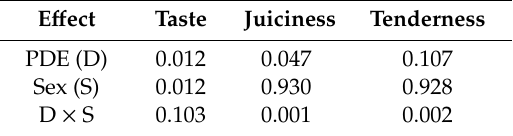
Table 8. The p values for PDE addition and pig-sex effects in a pork-meat consumers home test.